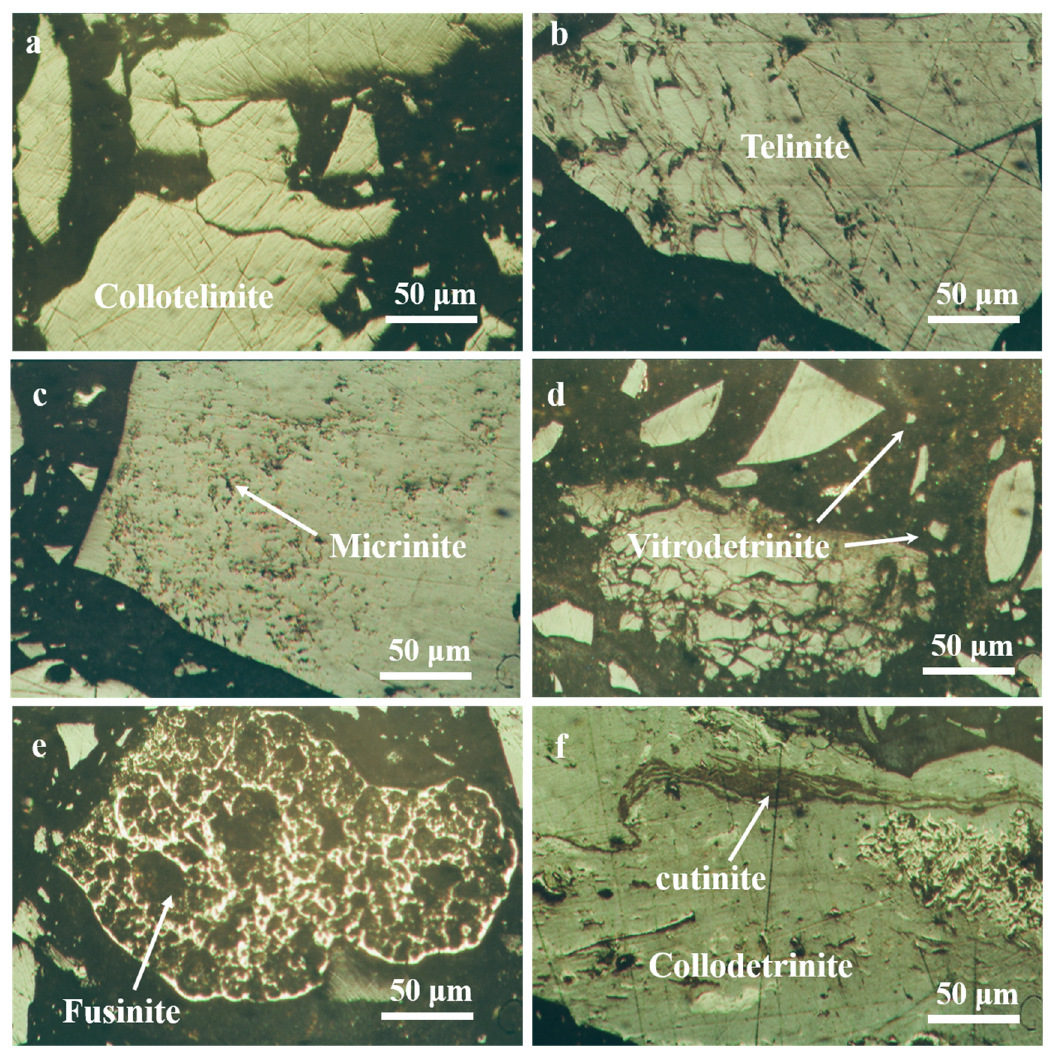
Figure 2. Microphotographs of macerals. ( a ) Sample NE3; ( b ) Sample NE7; ( c ) Sample NE13; ( d ) Sample NE26; ( e ) Sample NE25; ( f ) Sample NE10.